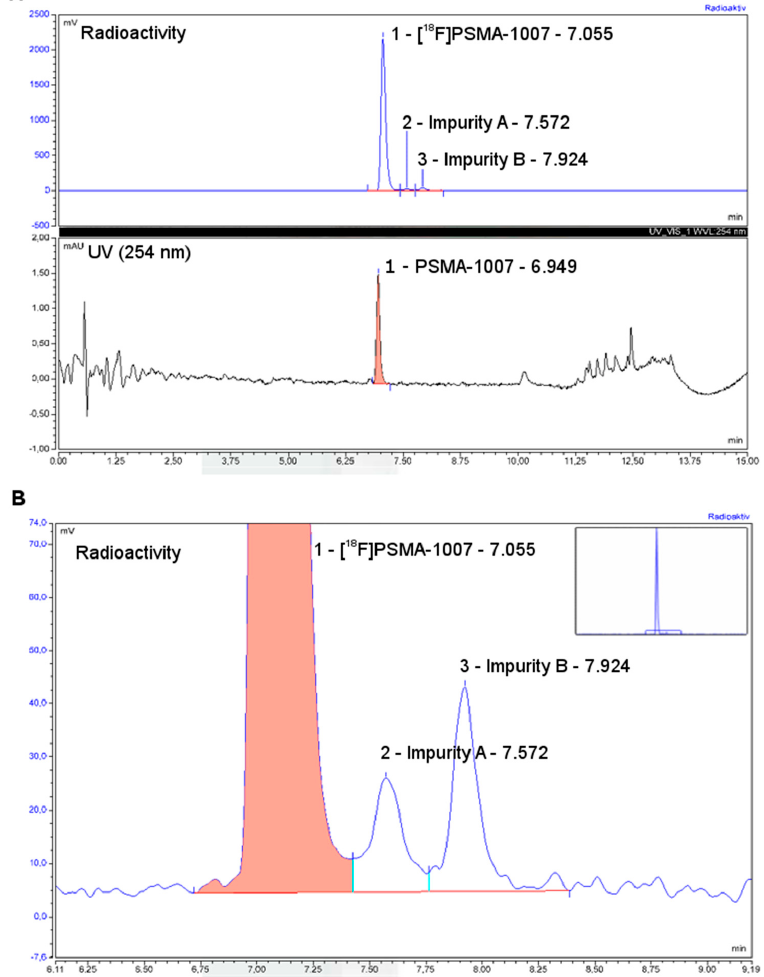
Figure 1. Relevant chromatograms for the release of [ 18 F]PSMA-1007 from the two-step production on the AllInOne radiosynthesiser: Full chromatogram of the [ 18 F]PSMA-1007 formulation showing co-elution of cold PSMA-1007 and radioactive product ( A ) and zoomed around the radioactive product peak ( B